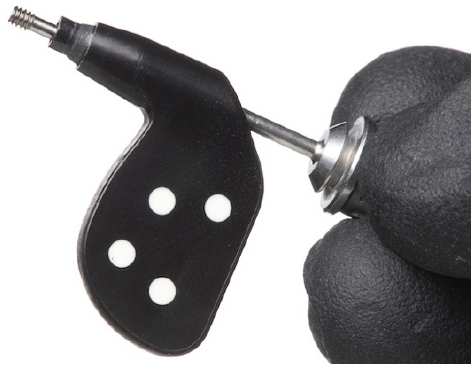
Figure 2. Implant level PiC transfer with an engaging configuration.